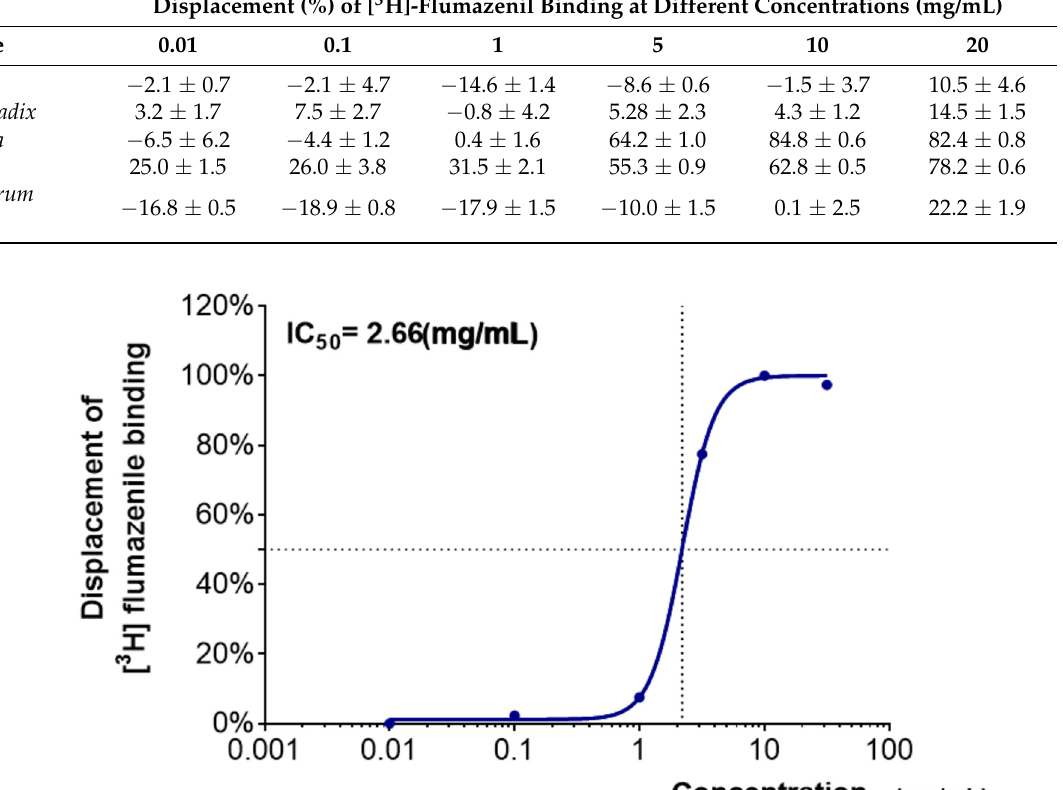
Figure 1. Dose–response curve of WCR in the GABA A –BZD-receptor-binding assay. Each data point represents the mean ± SD ( n = 3). Abbreviation: WCR, water extract of Coptidis Rhizoma